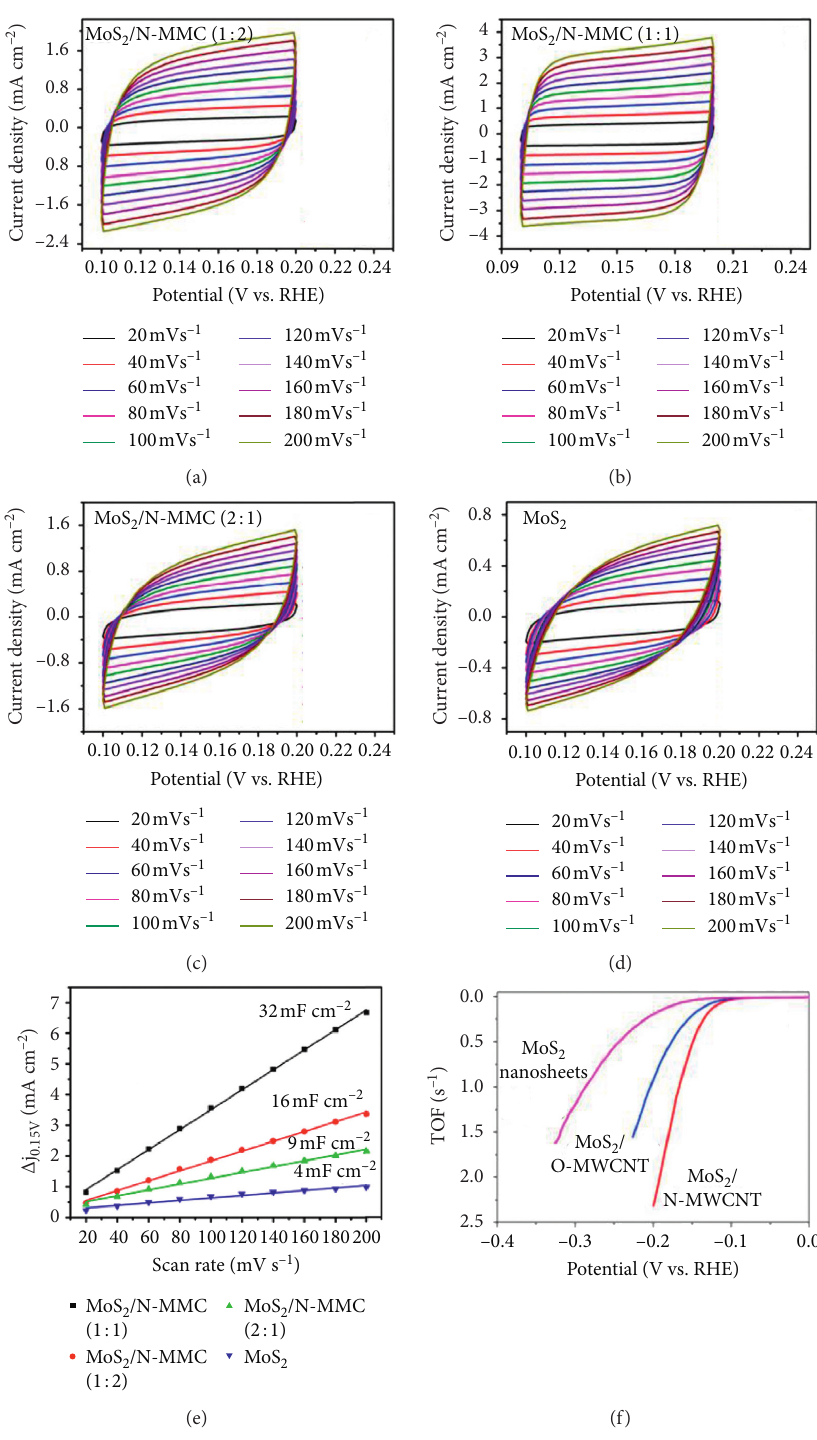
Figure 28: (a–d) Cyclic voltammogram of MoS 2 supported N-doped macromesoporous and their corresponding ECSA results (e) [154]. (f) TOF plot of MoS 2 -multiwalled carbon nanotubes physical processes that takes place in the electrolyte/elec- trode interface [156, 157]. This is achieved by getting in- formation on electrochemical characteristics such as double-